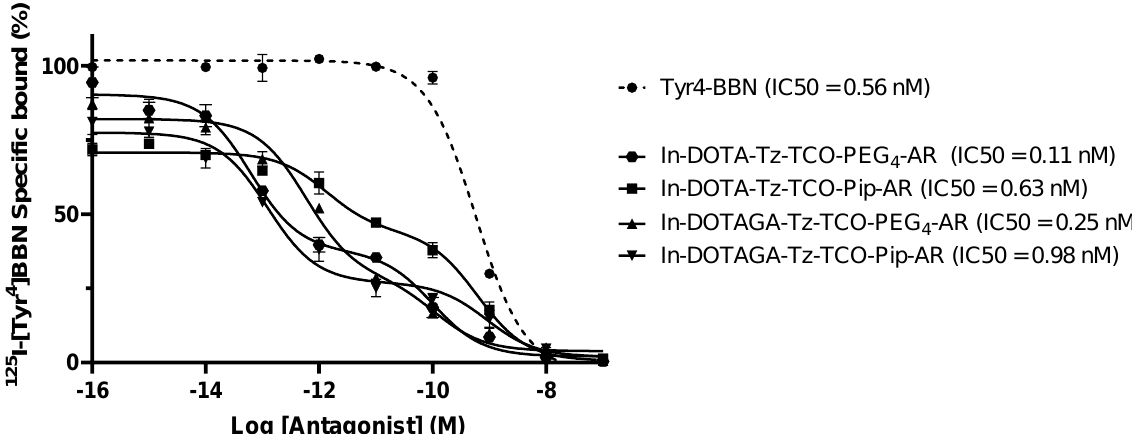
Figure 5. Displacement curves of [ 125 I]I-Tyr4-bombesin by the Tyr4-BBN and the four nat In-conjugates with respective IC50 values (corresponding to the lower affinity binding site).